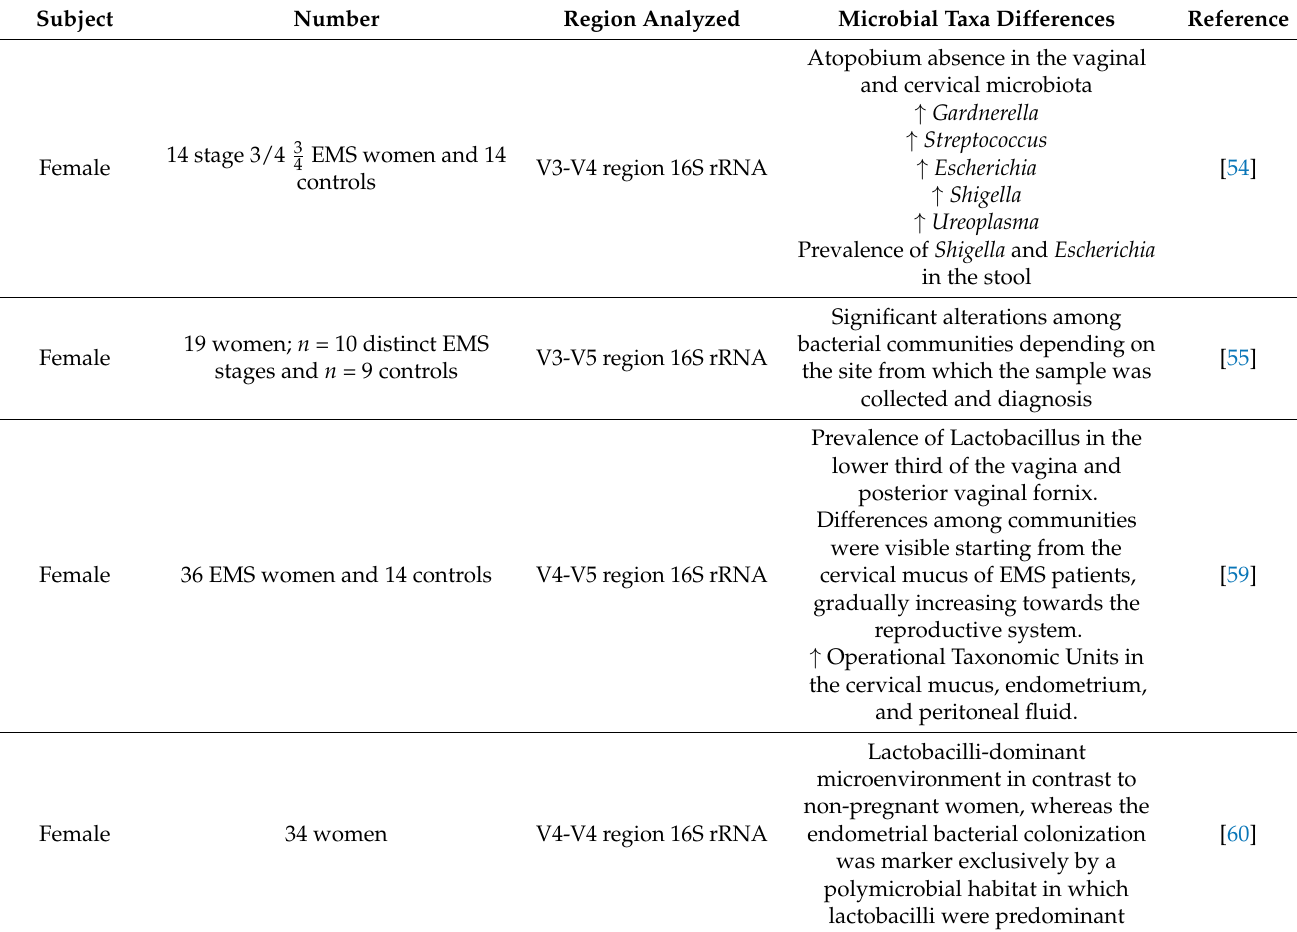
Table 3. Summary content regarding the outcomes in which we investigated the microbial taxa in EMS.